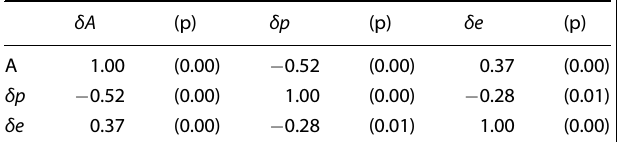
Table 2. Correlations among proportional area trend ( δ A), proportional population density trend ( δ p) and proportional per capita CO 2 emissions trend ( δ e